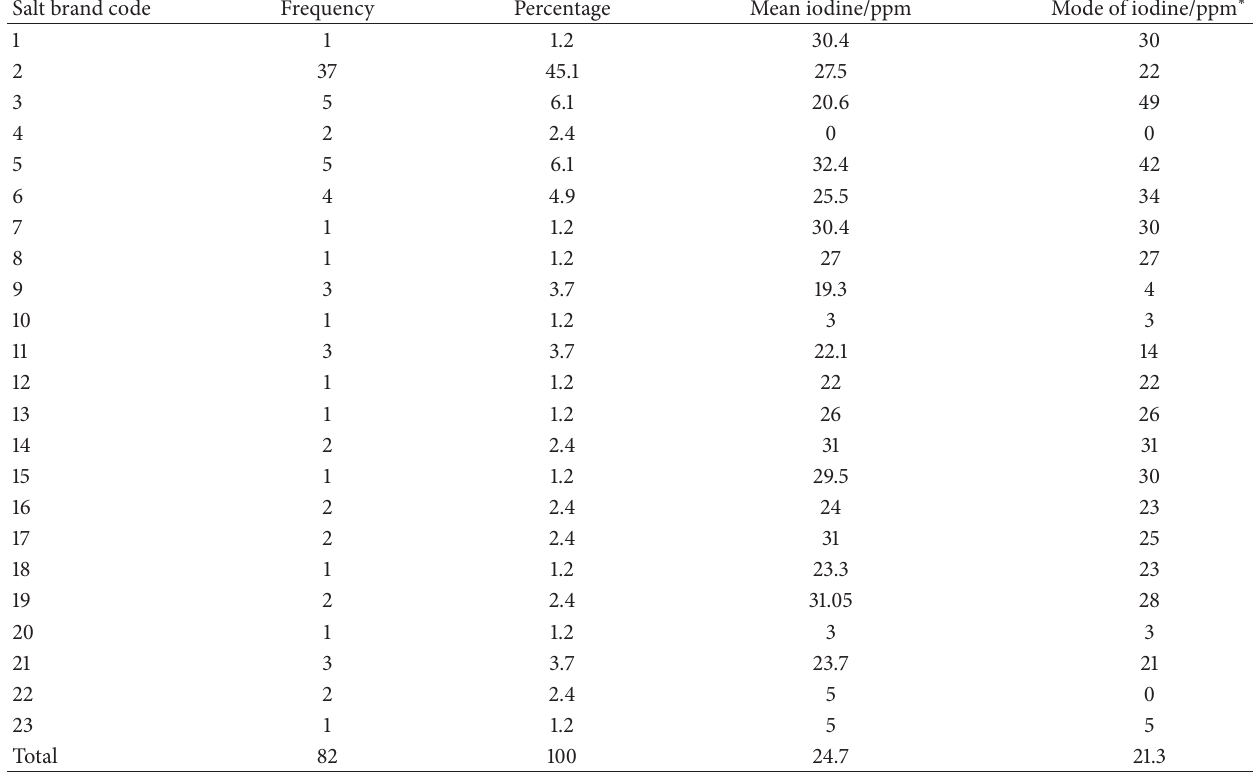
∗ ppm: Part per million.